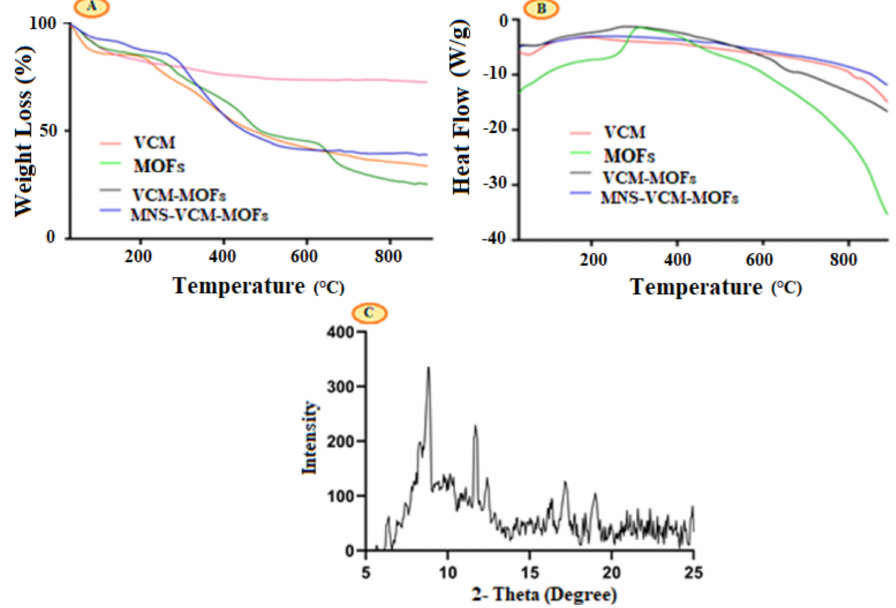
Figure 3. TG curve of VCM, MOFs, VCM − MOFs, and MNS − VCM − MOFs ( A ), DSC diagram of VCM, MOFs, VCM − MOFs, and MNS − VCM − MOFs ( B ), and P − XRD pattern ( C